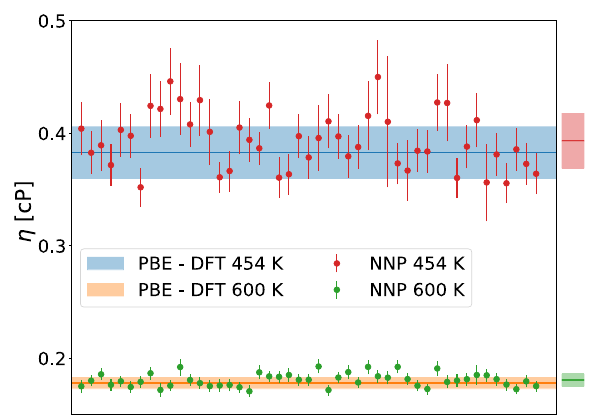
Fig. 4 Comparison between the shear viscosity predicted by DFT AIMD simulations and by DPMD simulations. The results are obtained from 400-ps long DFT AIMD simulations (horizontal blue and orange bands, 454 and 600 K, respectively) and by DPMD simulations of the same length (solid dots). The width of the bands and the vertical bars across the dots indicate the standard deviation of the data they refer to, as estimated by cepstral analysis (see Section “ Data analysis ” ). The red and green bars on the right of the box indicate the sample averages and standard deviations of the DPMD data. Error bars represent standard deviations. Table 1. Viscosity of water [cP] computed from AIMD or DPMD performed at two different temperatures using the PBE XC